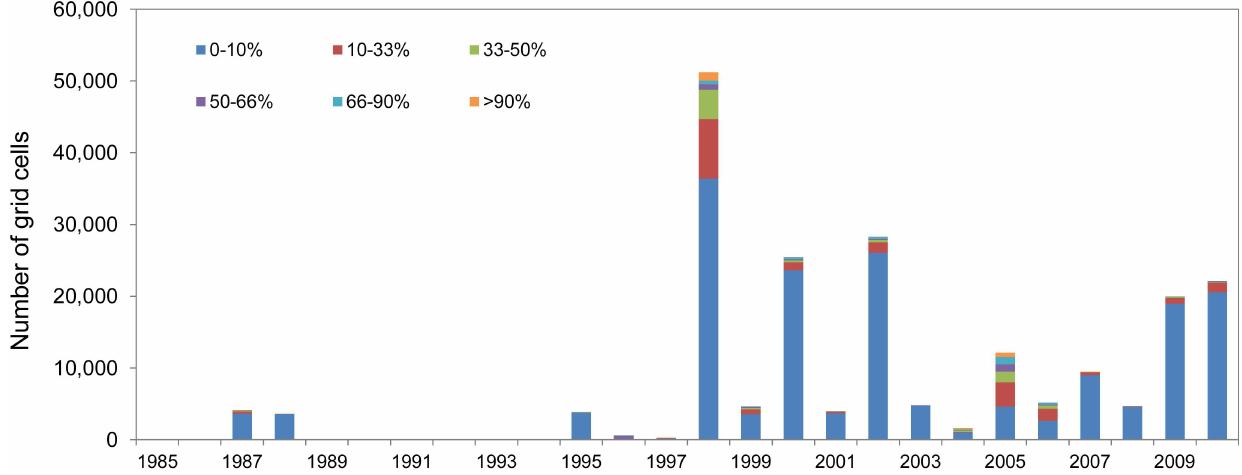
Fig 5. Number of 0.04˚ × 0.04˚ latitude-longitude grid cells with different estimated probabilities of bleaching from 1985–2010. Note that the density of bleaching reports was too low in years 1985, 1986, and 1989–94for the interpolationto succeed.